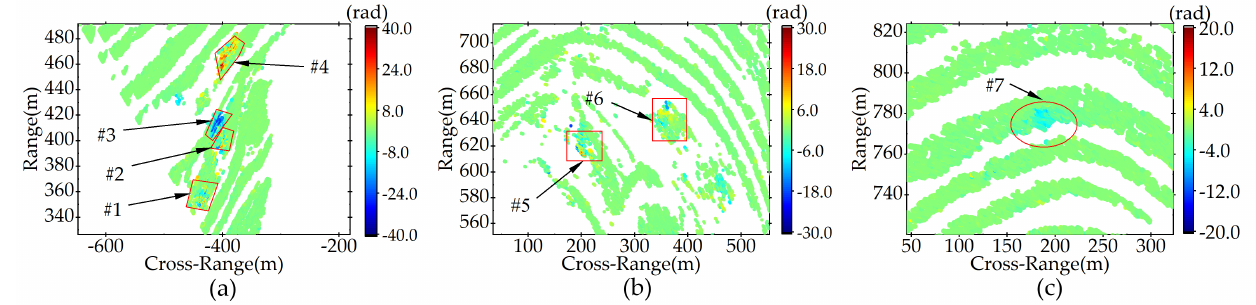
Figure 24. Details of ( a ) area A, ( b ) area B and ( c ) area C, the larger potential deformation areas are marked as #1–#7, respectively.